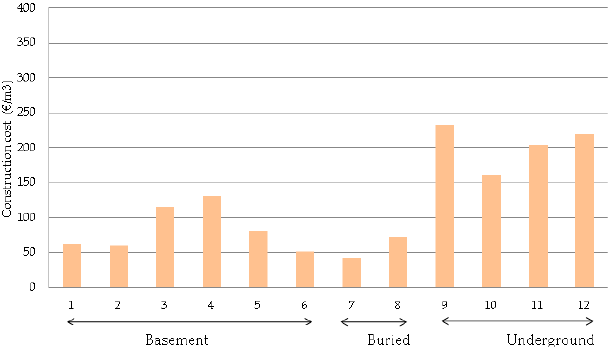
Figure 9. Construction costs associated with each of the analyzed warehouses.